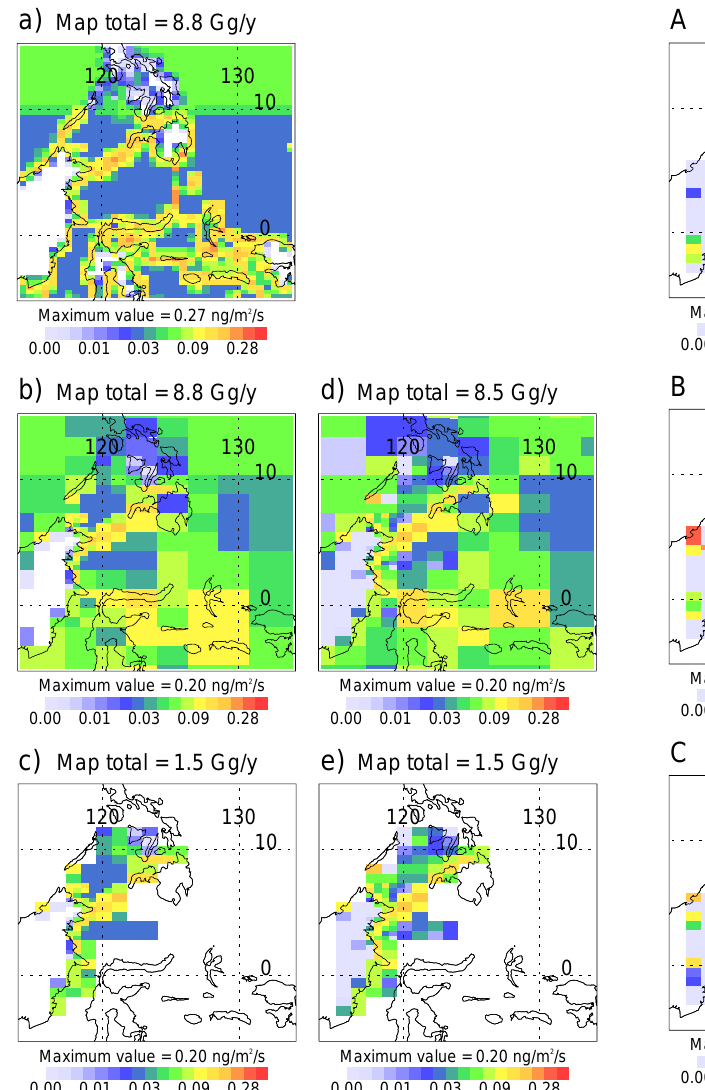
Fig. 5. (a) Shows CHBr 3 emissions according to the Pyle et al. (2011) update to scenario 5 in Warwick et al. (2006) after re- gridding to match NAME’s grid. These emissions are used to cre- ate pseudo observations. (b) Shows these emissions degraded to the resolution of the solution grid (see Fig. 3), and (c) shows these de- graded emissions when only the “fine” solution grid cells are in- cluded. For comparison, (d) shows the mean solution of 25 inver- sions which use pseudo observations derived from the emissions in (a) , and (e) shows this mean solution when only the “fine” grid cells are included. The total emission from the plotted grid cells is noted above each plot (units are GgCHBr 3 yr − 1 ), and the colour scale is exponential.